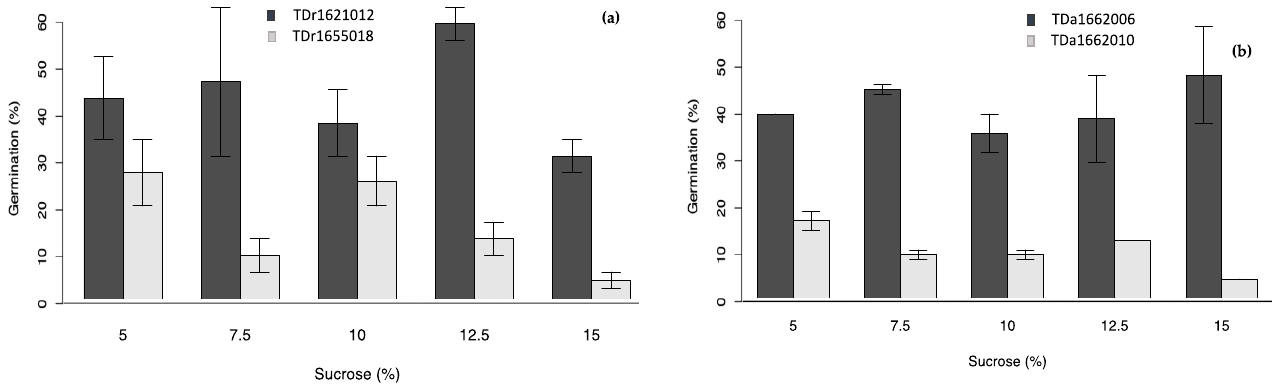
Figure 4. Effects of sucrose on pollen germination of genotypes of ( a ) D. rotundata , ( b ) D. alata.